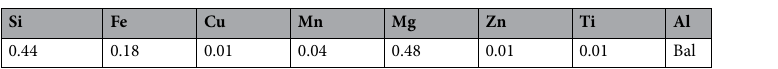
Table 2. Al 6063 chemical composition (weight percentage, wt%).